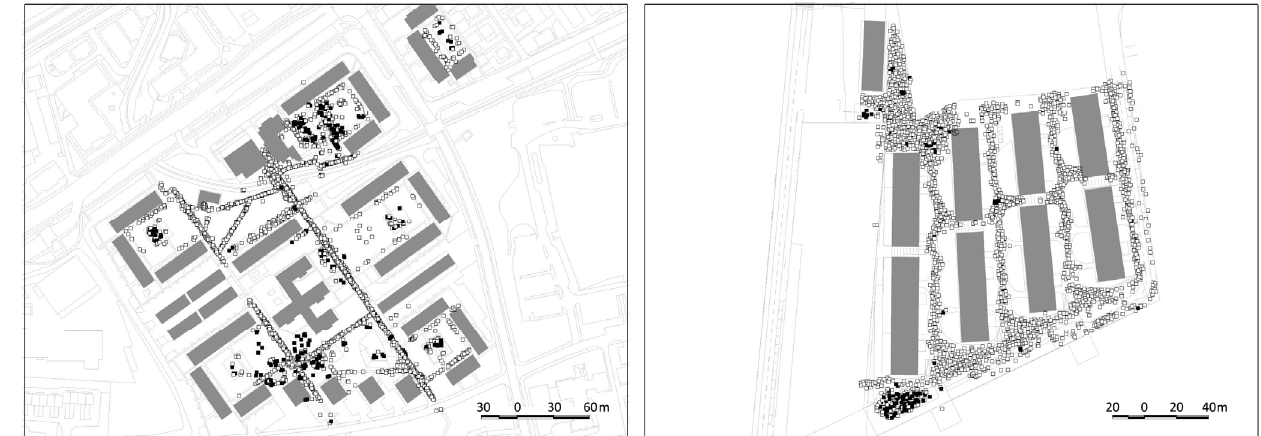
Figure 3. Left: Results of observations and behavioural mapping in Bonifacija showing the category “active in space”, filtered to show age groups 1 and 2 (up to 12 years) (black spots) in relation to other activities observed in the same time (white spots). Right: Results of observations and behavioural mapping in Mesarska showing the category of activity “active in space”, filtered to show age groups 1 and 2 (up to 12 years) in relation to other activities observed in the same